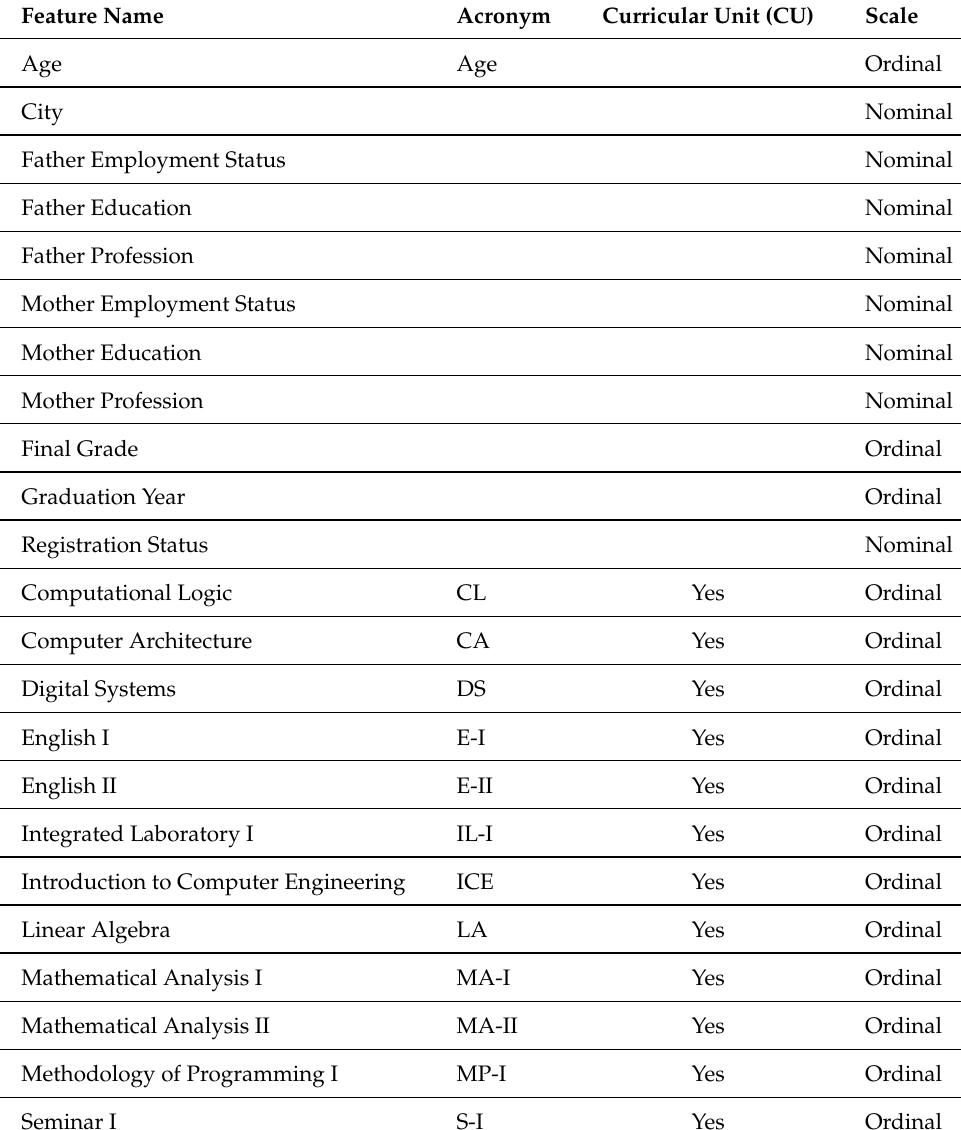
Table 2. Initial dataset